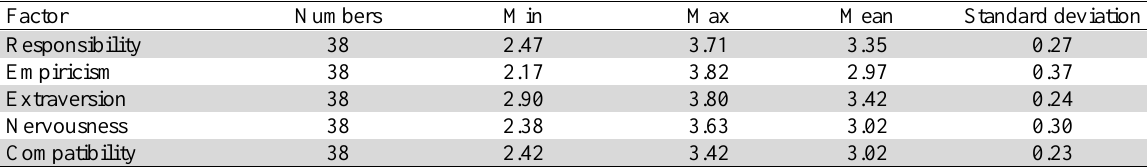
The summary of basic statistics